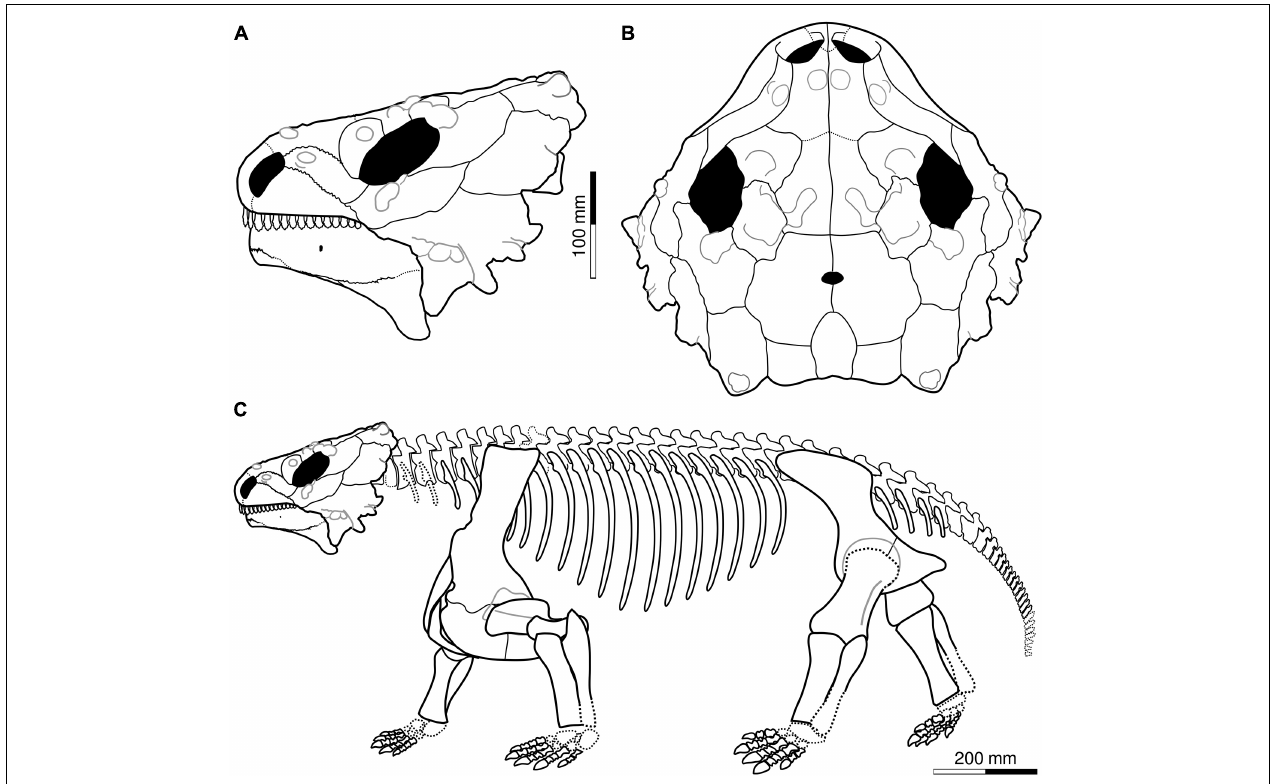
FIGURE 3 | Cranial reconstruction of Provelosaurus americanus in (A) lateral and (B) dorsal view. Antorbital region based on holotype, posterior skull roof and temporal region (minus jugal-squamosal suture) based on UFRGS-PV-0358-P, mandible after UFRGS-PV-0359-P. (C) Skeletal reconstruction, postcranium based largely on UFRGS-PV-0233-P; scapulocoracoid after UFRGS-PV-0231-P; clavicle, interclavicle and humerus from UFRGS-PV-0359-P. Osteoderms omitted.